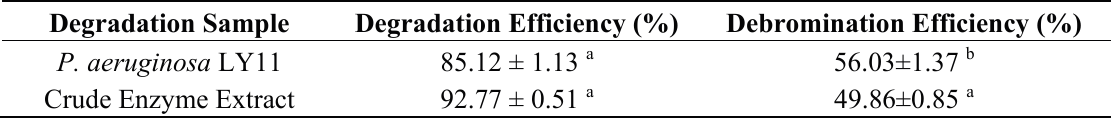
Table 1. The contrast biodegradation of BDE-209 between P. aeruginosa LY11 and crude enzyme extract under optimal conditions. The optimal biodegradation condition of LY11 was set at cell age 36 h, inoculation amount 40 mg, initial concentration 20 mg/L, 35 °C, pH 7.0 and 5 days. The optimal biodegradation condition of crude enzyme extract was set at protein content 2000 mg/L, initial concentration 20 mg/L, 35 °C, pH 9.0 and 5